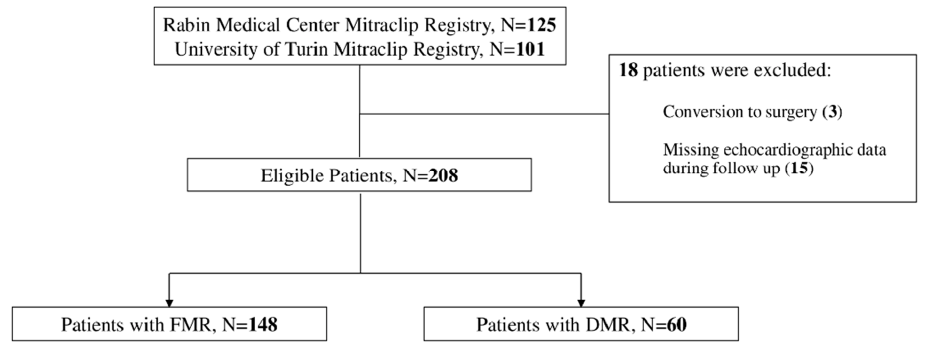
Figure 1. Patient Flow Chart.